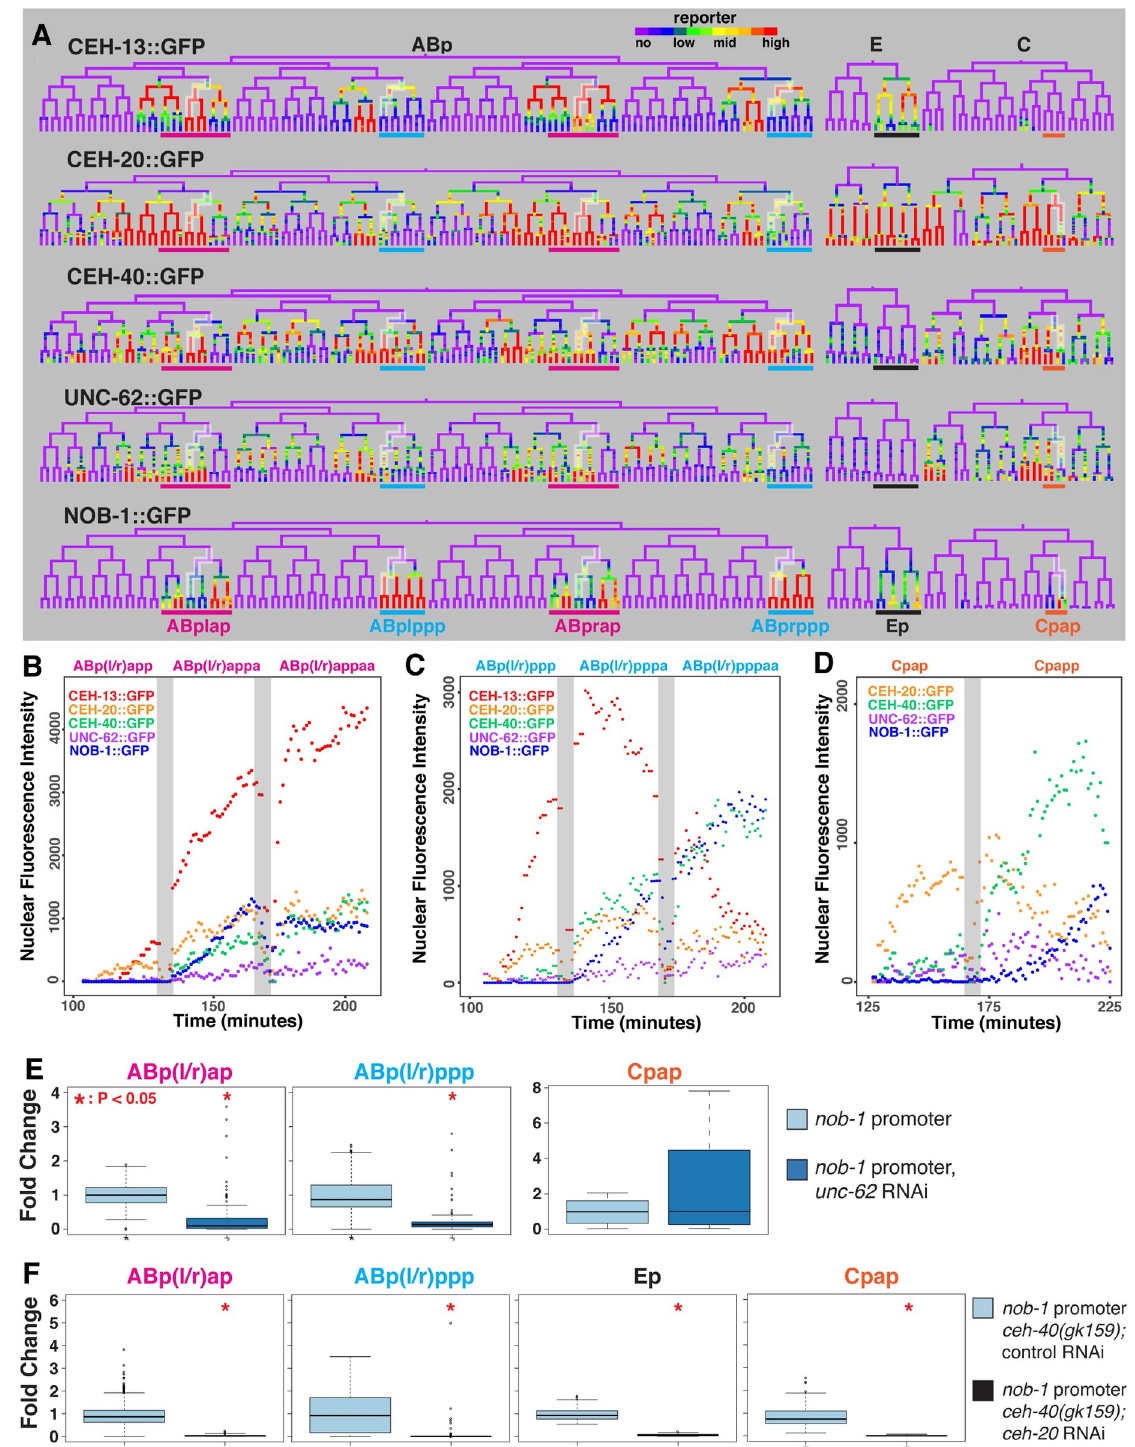
Fig 4. Hox co-factors precede nob-1 and regulate its expression. A) Trees of NOB-1::GFP expressing lineages, ABp, E, and C, showing the expression of ceh-13 (fosmid) and nob-1 (GFP transgene) reporters, and fosmid GFP transgene reporters for the Hox co-factor genes, ceh- 20 , ceh-40 and unc-62 . Color thresholds were adjusted for each reporter to show all expressing cells. Highlighted branches are shown in graphs B, C, and D. B-D) Average TF reporter nuclear fluorescence intensity across embryos (n � 2) and for left/right symmetric cells across developmental time for the cells leading to B) ABp(l/r)appaa, C) ABp(l/r)pppaa and D) Cpapp. Fluorescence intensity is in arbitrary units